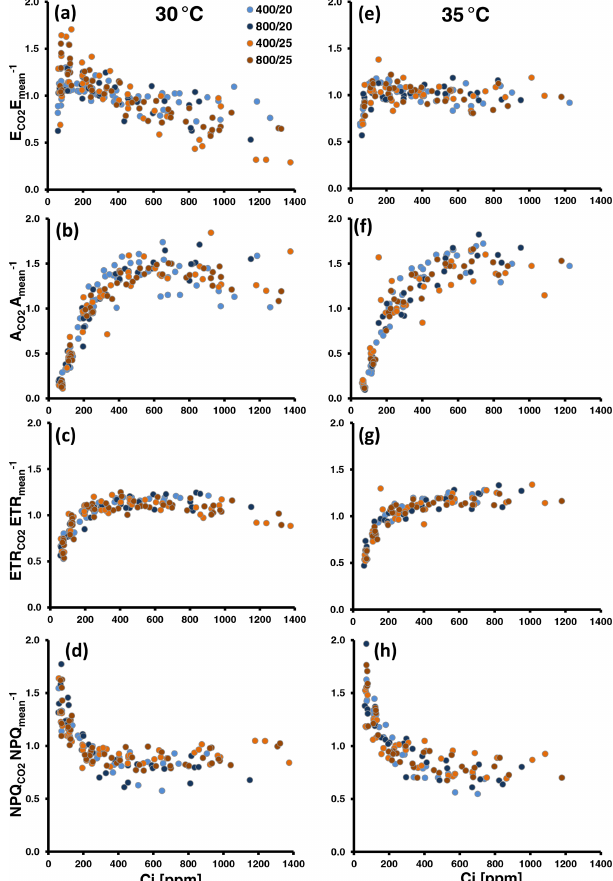
Figure 2. Normalized MT emissions (a, e) , CO 2 assimilation (b, f) , the electron transport rate (ETR; c , g ) and non-photochemical quenching (NPQ; d , g ) against leaf-internal CO 2 concentration (Ci) measured during CO 2 ramping at assay temperatures of 30 ◦ C ( a, b, c, d ) and 35 ◦ C ( e, f, g, h ). Altogether, 26 and 20 CO 2 -response curves were run at 30 and 35 ◦ C, respectively. Colors of the dots de- note the temperature and CO 2 regimes in which plants were grown. Data were normalized by devising the individual data points of a CO 2 -response curve by their mean. To compare the overall ampli- tude of responses, all y axes were set to the same scale.